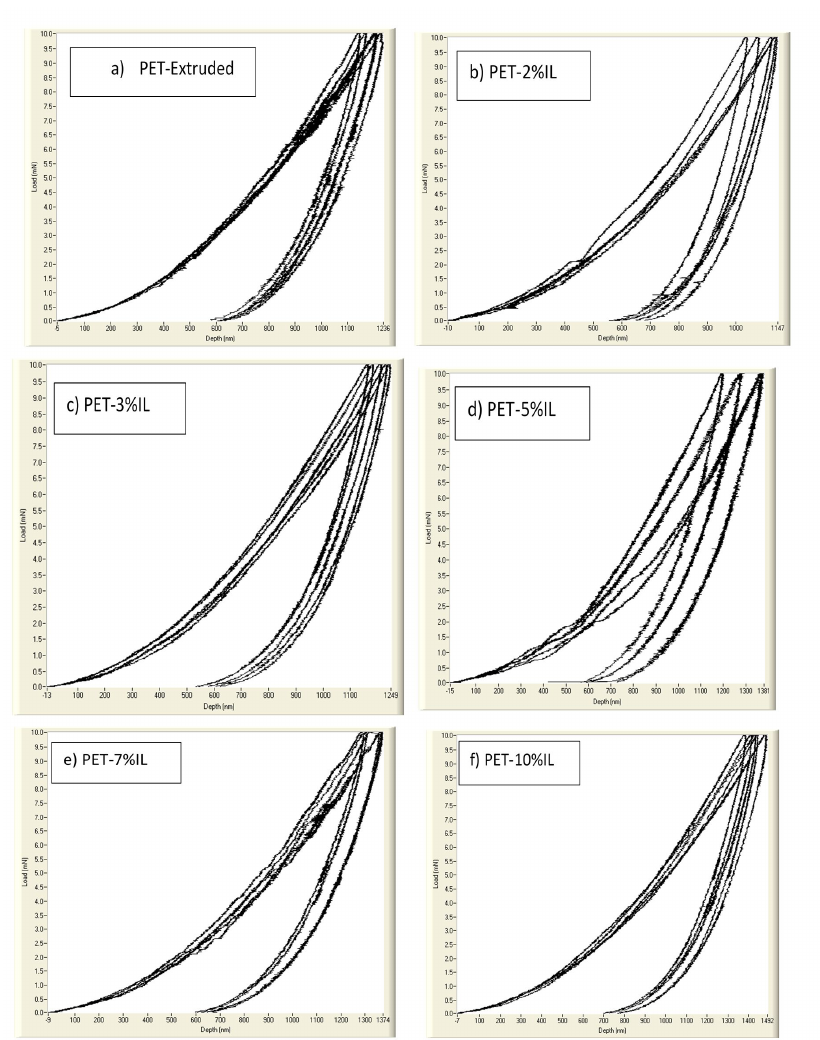
Figure 7. Loading–unloading curves of the nanoindentation tests for the PET-IL blends (a) PET (b) PET-2% IL (c) PET-3%IL (d) PET- 5%IL (d) PET-7% IL (f)